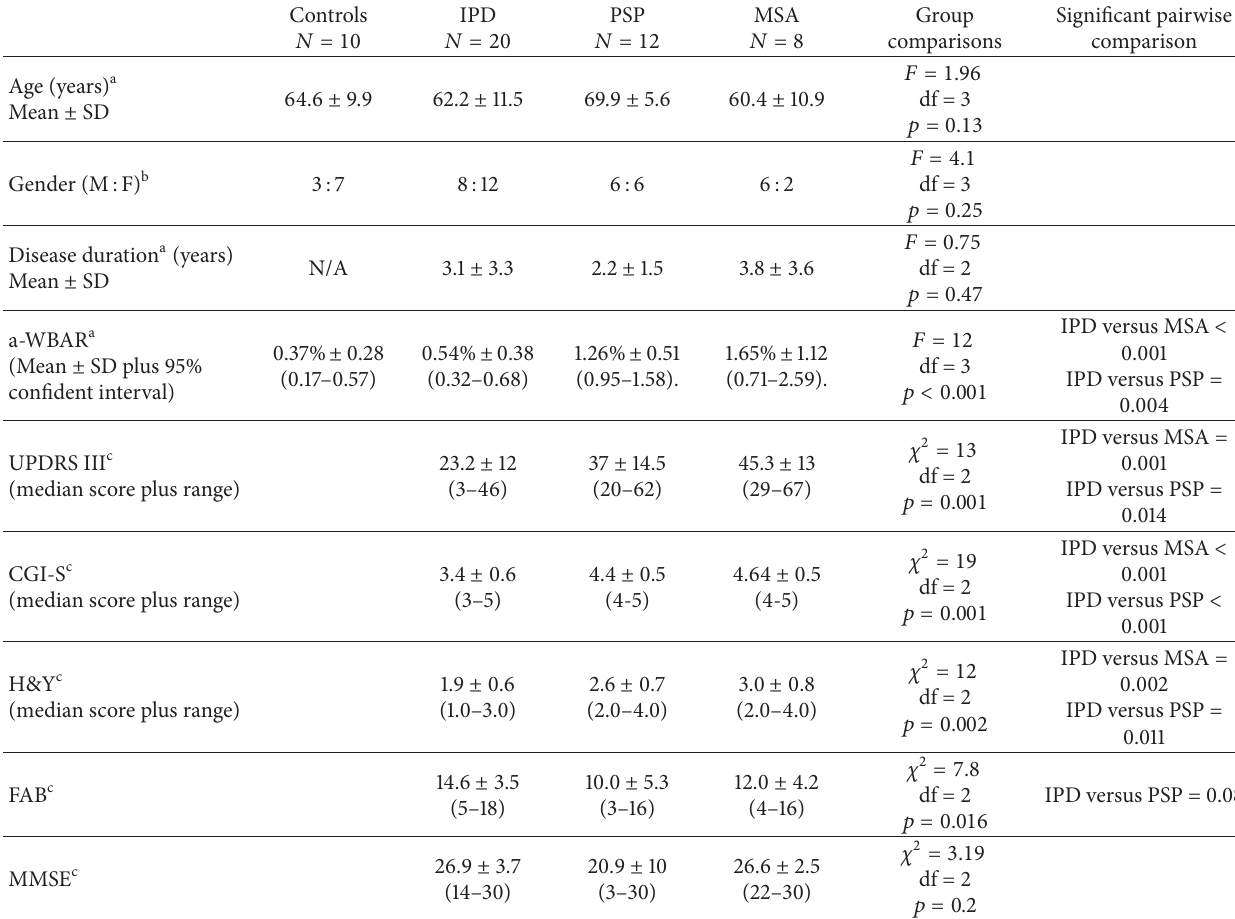
Table 1: Baseline demographics, clinical features, and